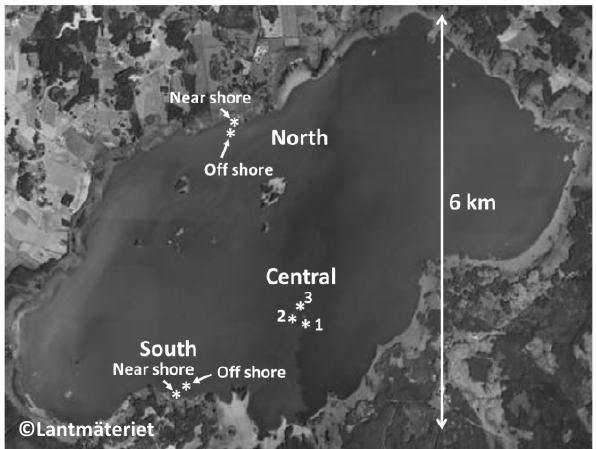
Figure 2. Comparison of CO 2 mixing ratio (ppm) measured with a Los Gatos Research greenhouse gas analyzer (LGR; DLT100) and the Senseair (ELG) CO 2 logger. Measurements were made with ELG loggers from two different batches at two separate occasions (diamonds forming bold lines and circles). The ELGs have a max- imum limit at 10000ppm in their present configuration. The LGR is affected by saturation/quenching effects in the measurement cell starting at 6000ppm, explaining the slight offset compared to the 1 : 1